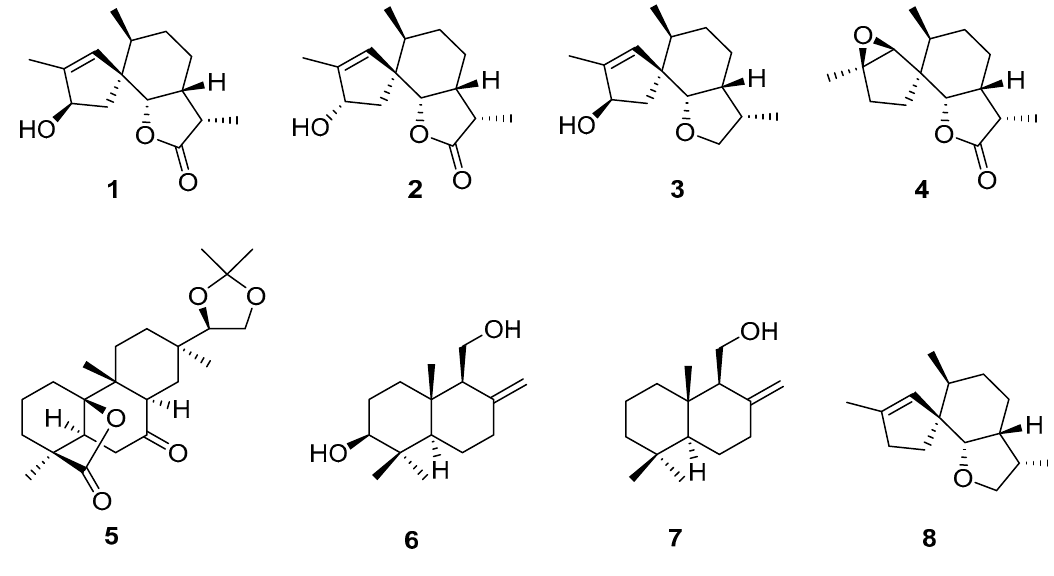
Figure 2. Terpenoids from C. versicolor.